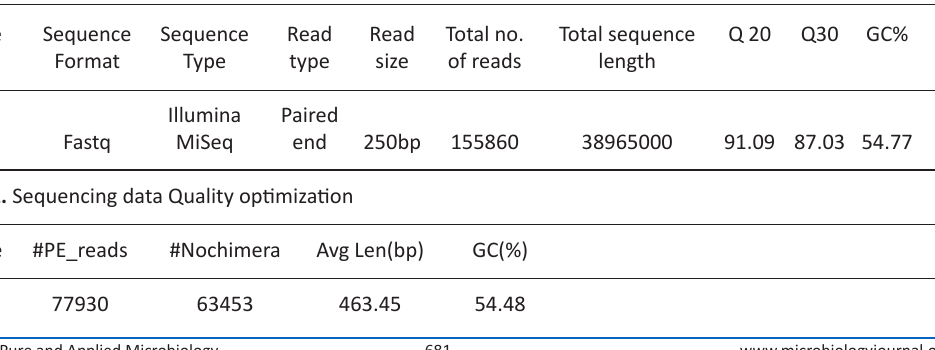
Table 1. Preliminary data statistics Sample